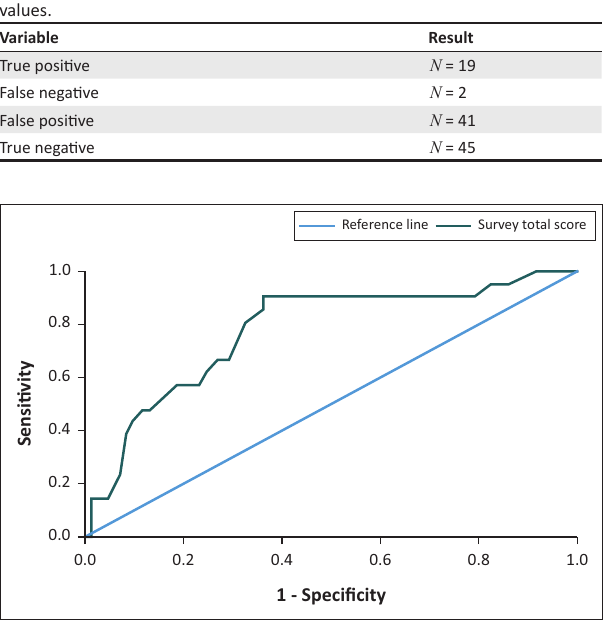
FIGURE 1: ROC Curve showing the AUC for the online adapted